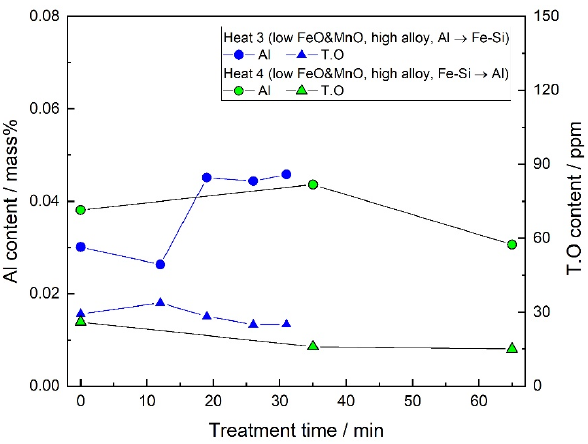
Figure 8. Comparison of the Al and total oxygen contents between heat 3 and heat 4.